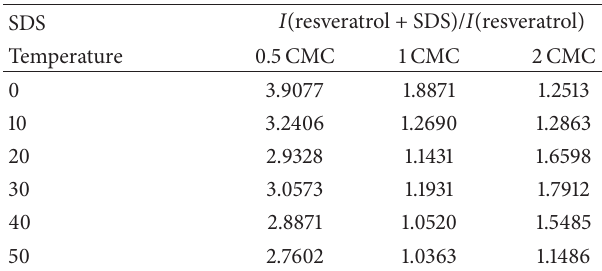
Table 1: Intensity ratio between emission of resveratrol in presence of SDS and resveratrol in water.